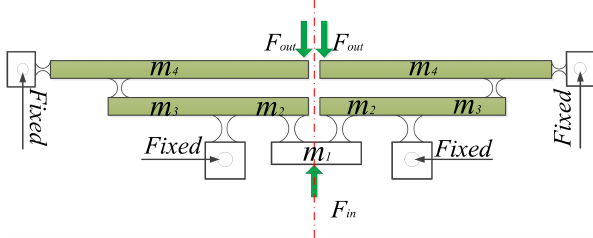
Figure 2. Symmetrical structure with two 2-stage